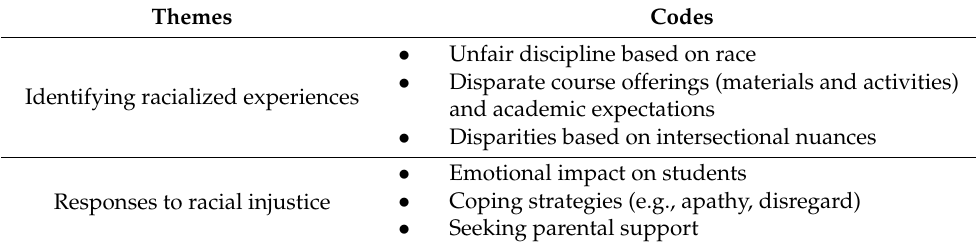
Table 2. Themes and